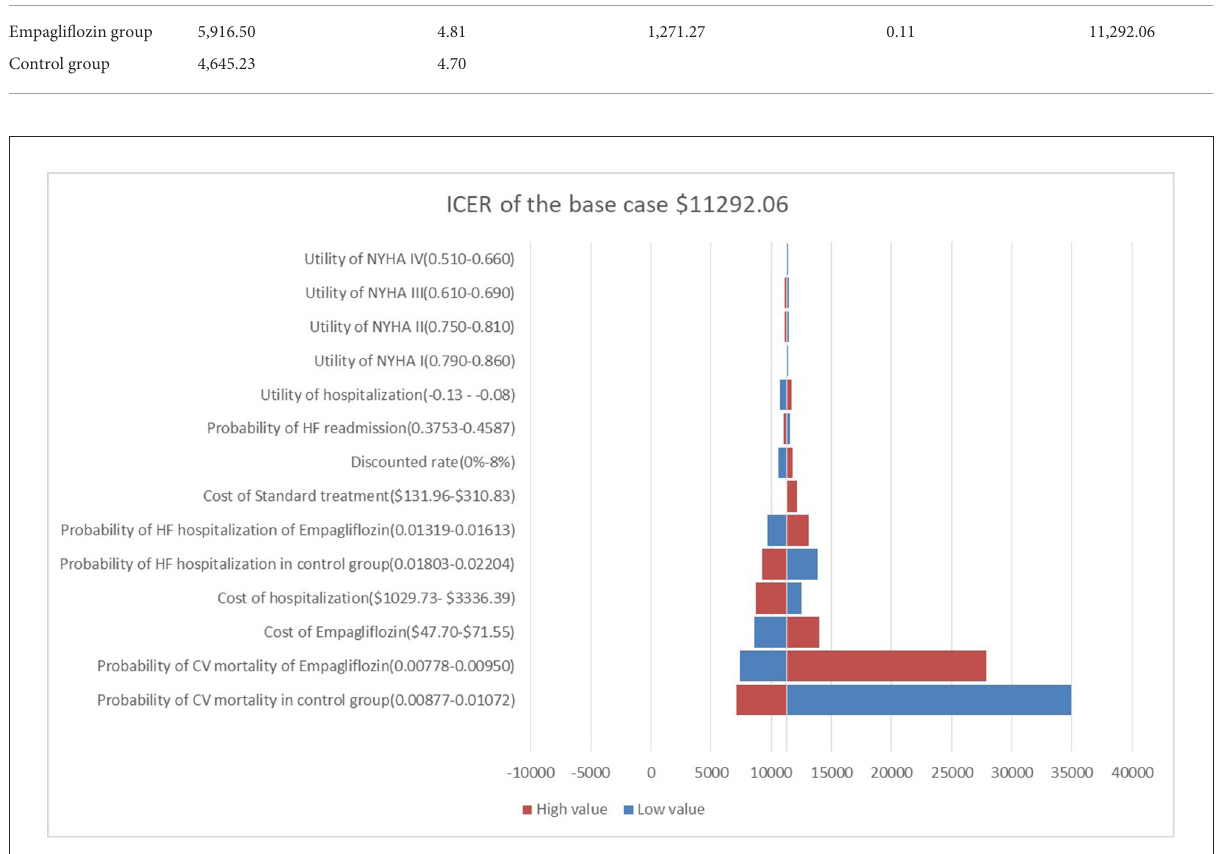
FIGURE2 Tornado diagram showing the univariate sensitivity analysis of the Markov model